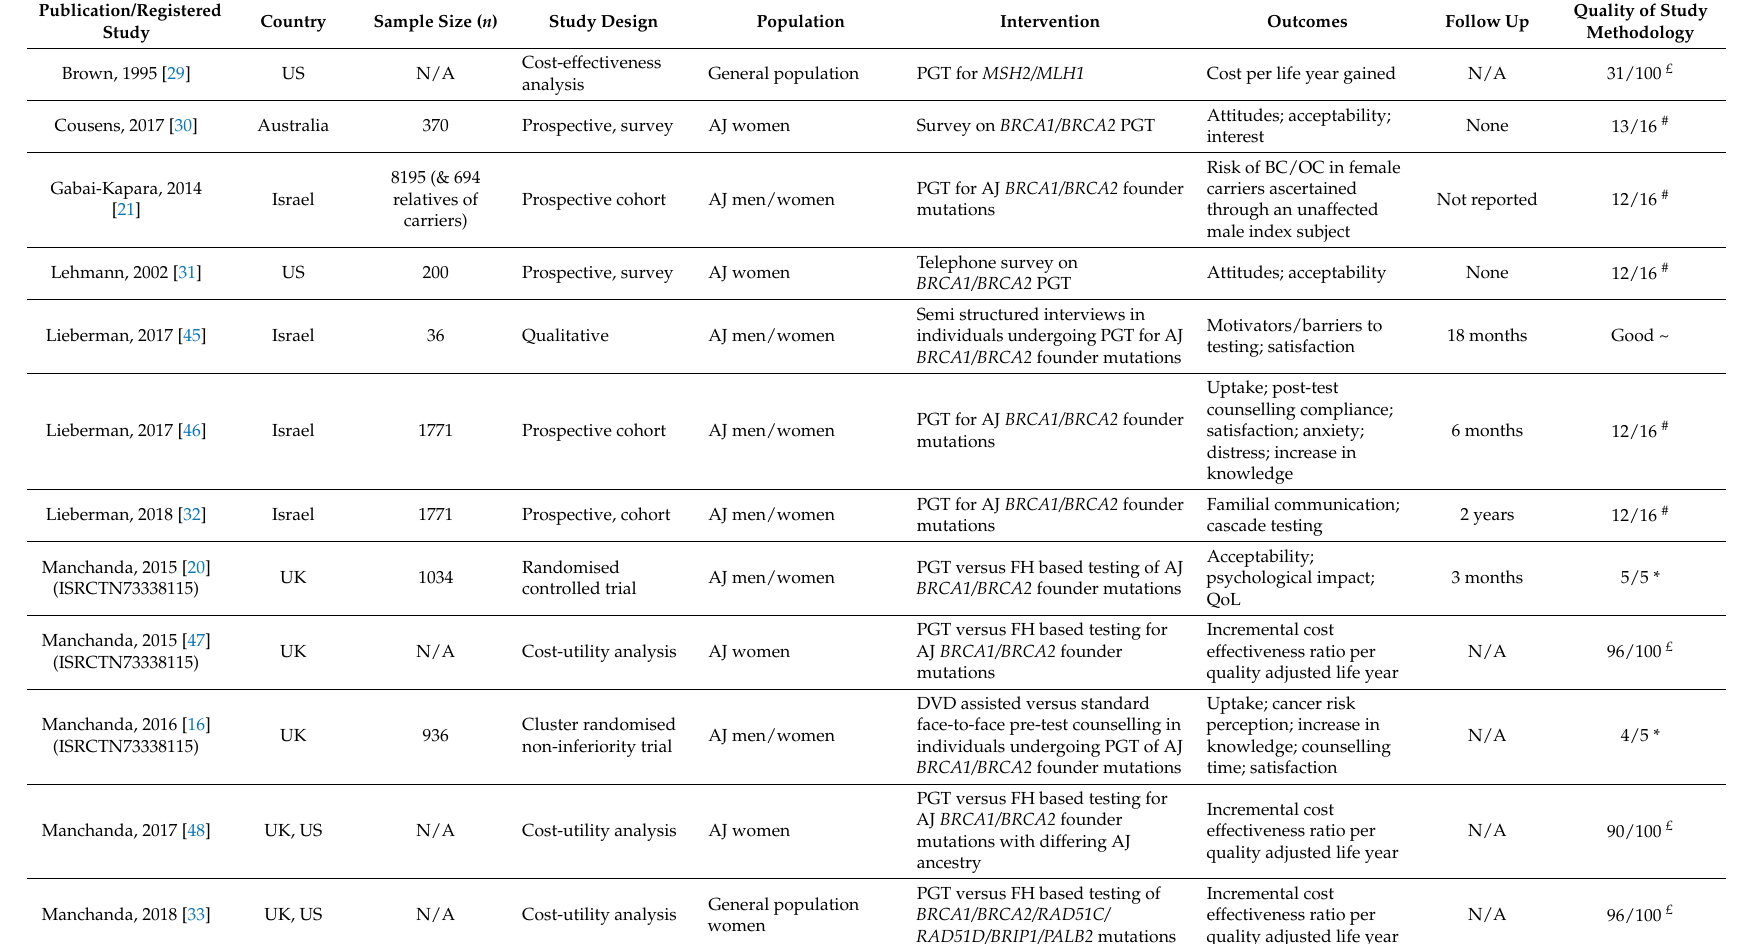
Table 2. Publications and registered studies reporting population genetic testing